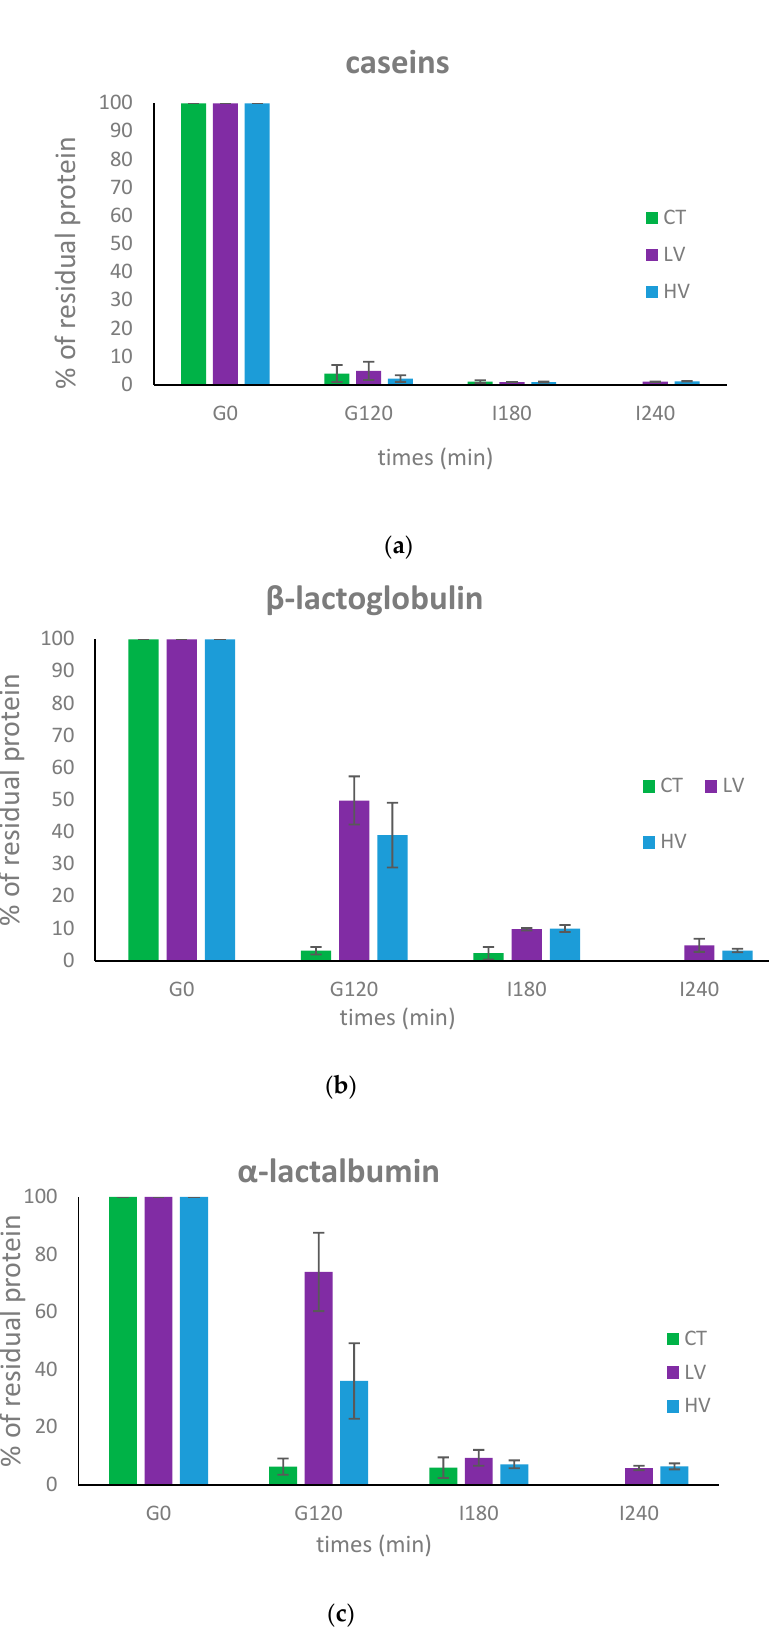
Figure 4. Residual % of casein ( a ), β -lactoglobulin ( b ), and α -lactalbumin ( c ) before digestion (G0), after 120 gastric digestion (G120) and after 180 (I180) and 240 (I240) min of intestinal digestion in the control (green), low viscosity (violet), and high viscosity (blue) yogurts.